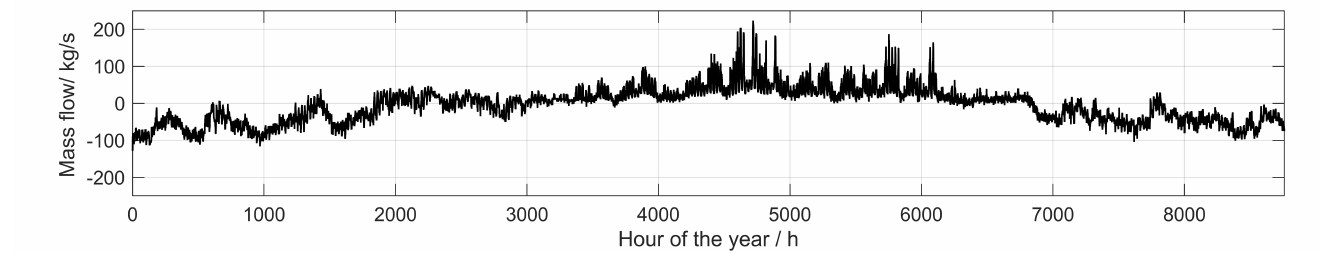
Figure 14. Annual performance of the BTES: Mass flow of all 349 probes connected in parallel within the